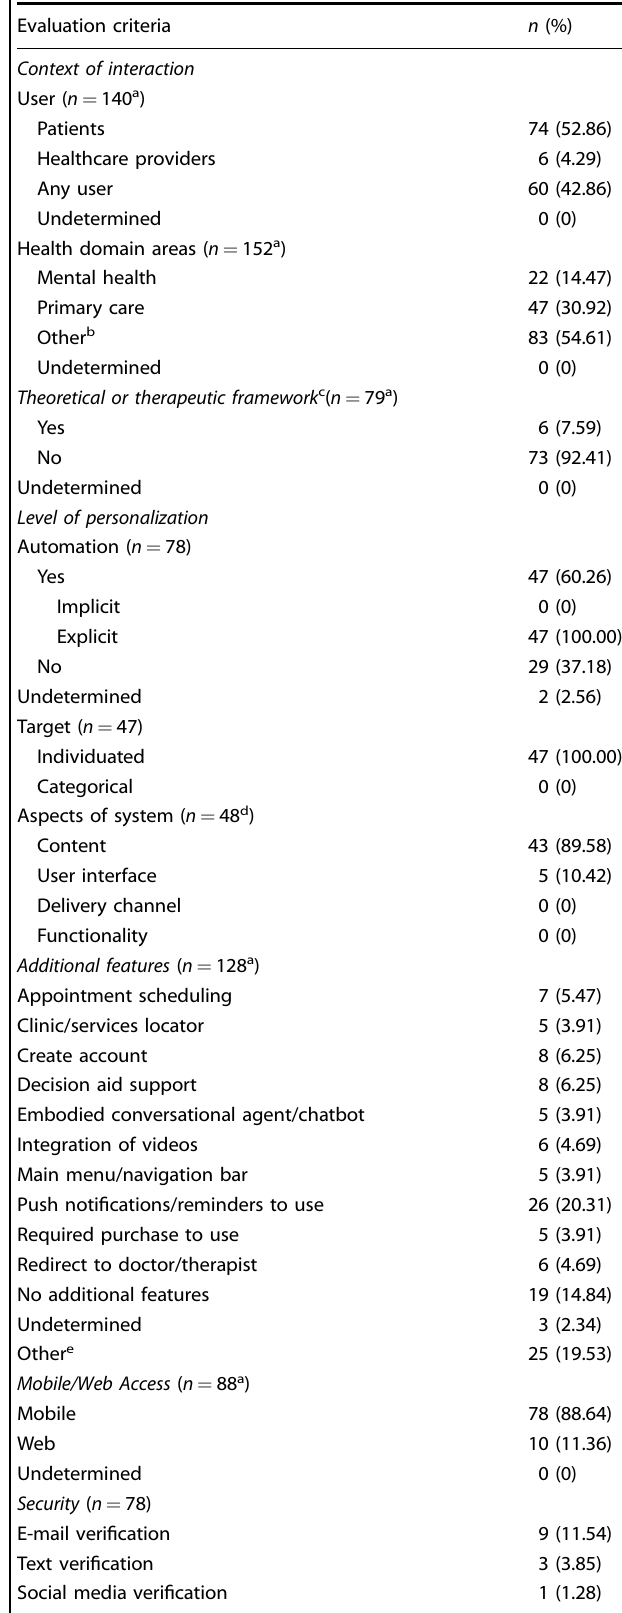
Table 1. Characterization of the Chatbot — Health Contexts and Core